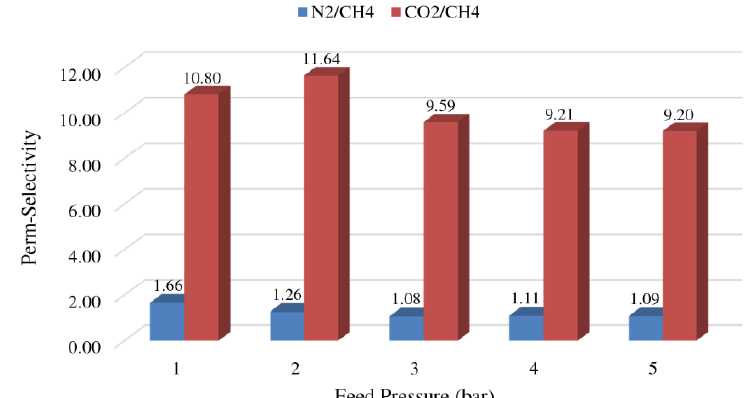
Figure 7. Comparison of the perm-selectivity of the CO 2 /CH 4 and N 2 /CH 4 through the DD3R membrane as a function of feed pressure at room